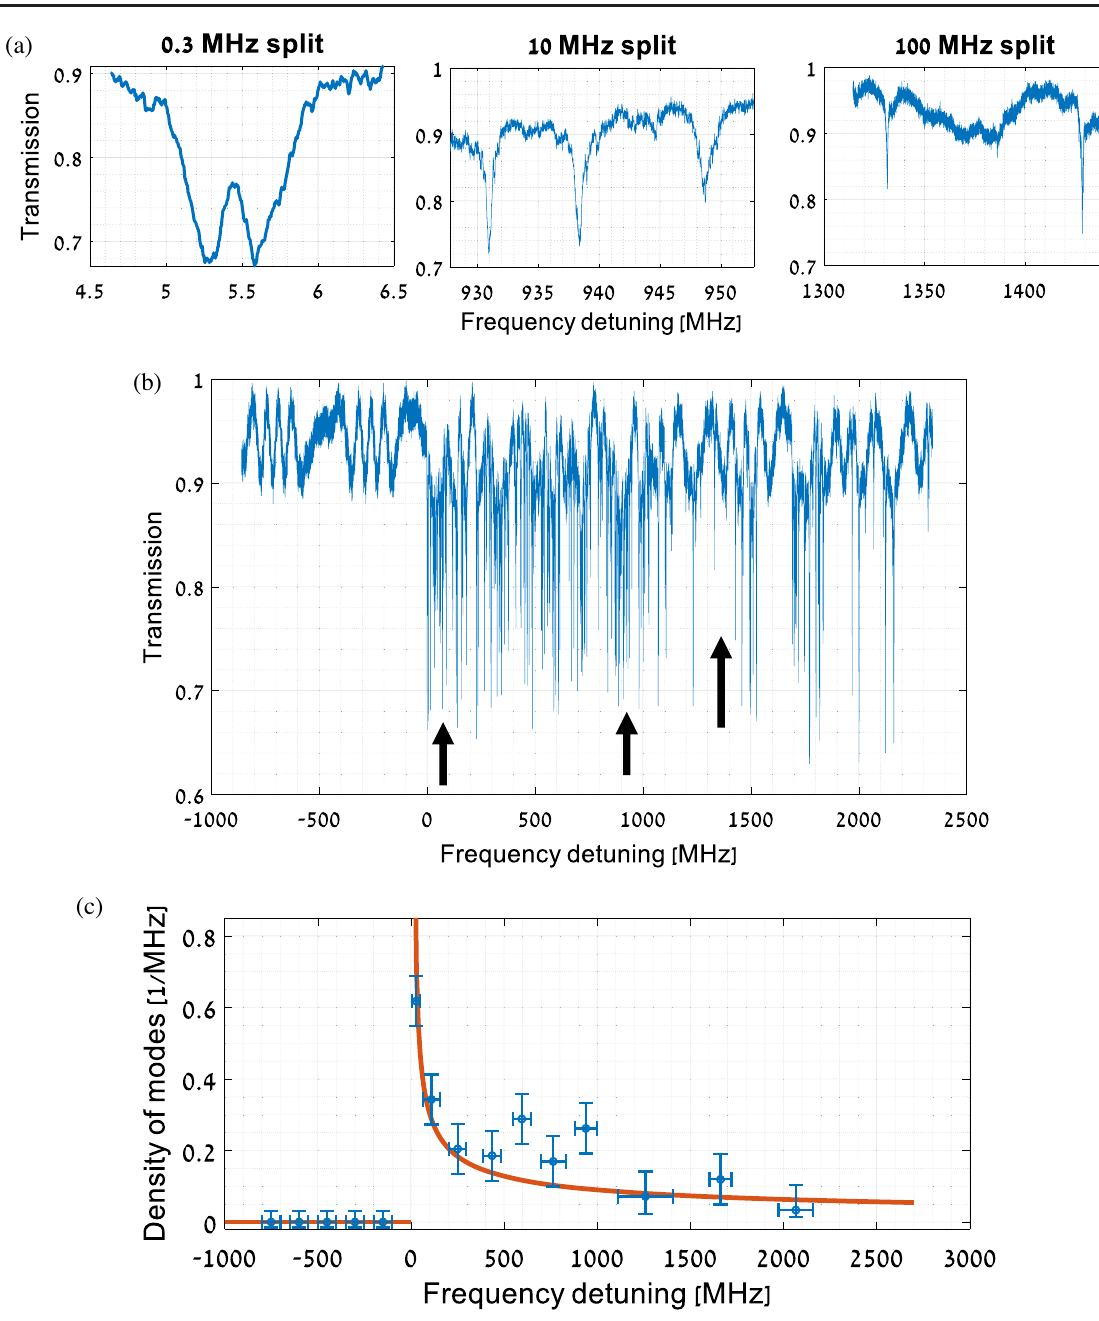
FIG. 4. Density of modes. The spectral transmission of the levitating resonator (a),(b) indicates no resonances at the left-hand side of (b), followed by dense resonances [(b), middle], and then fewer resonances per frequency span [(b), right-hand side]. Panel (a) represents an enlargement of spectral regions that are marked by an arrow in (b). (c) The experimentally measured density of modes (blue) as a function of the laser frequency, next to a theoretical fit using Eq. (SM12) [25] (orange). λ ¼ 980 nm, r ¼ 13 . 5 μ m, n ¼ 1 . 4 , l ¼ 113 , and degeneracy order is 227. Frequency error bars reflect standard deviation, and density-of-modes error bars reflect our estimation for fault counting of resonances. The irregular transmission background originates from fluctuations in the power of our pump